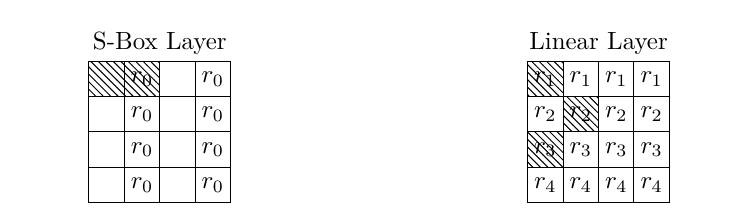
= r + r + r ) which is added after the layers. 4 1 2 3